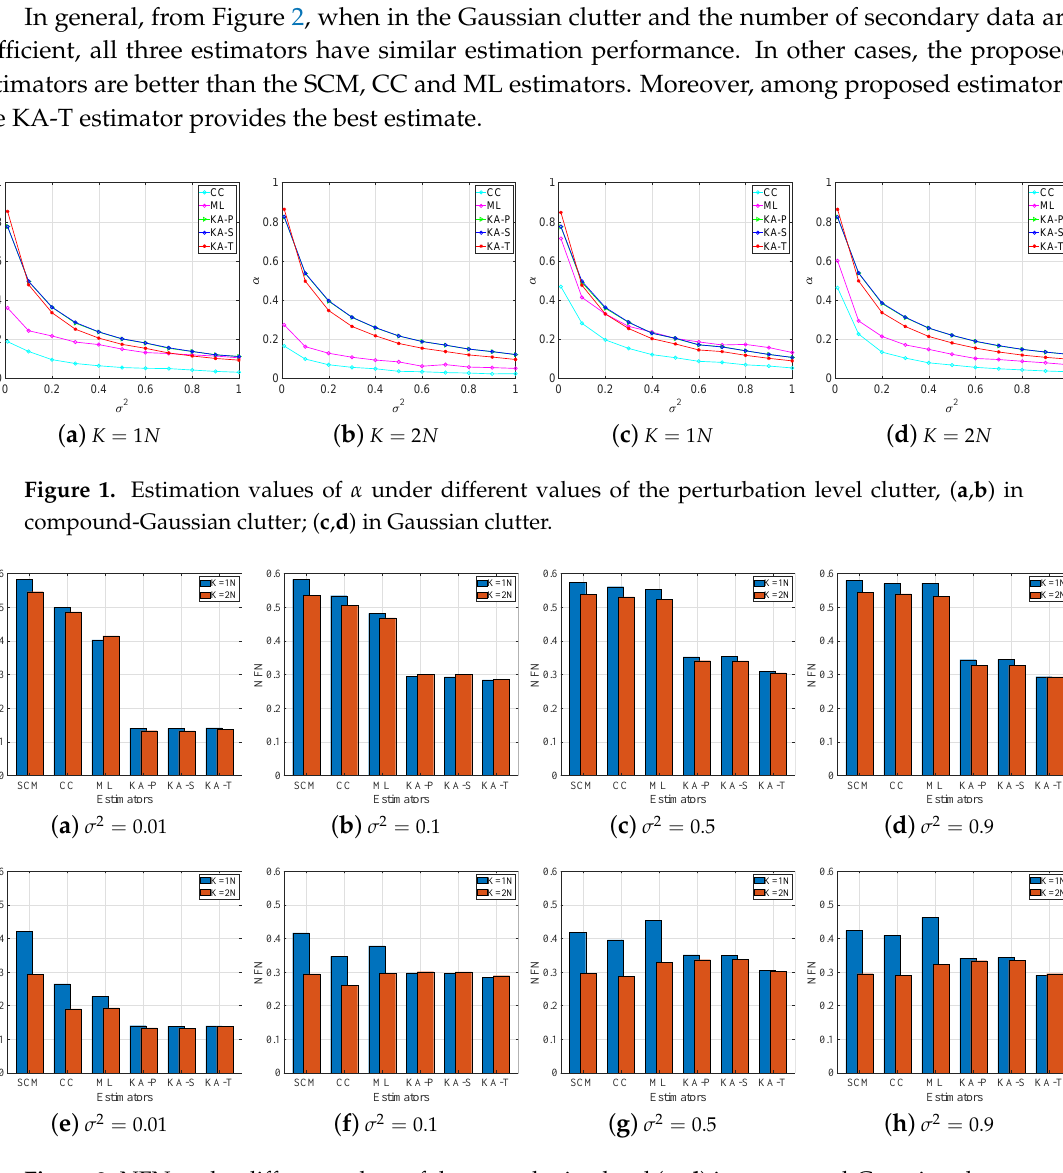
Figure 2. NFN under different values of the perturbation level ( a – d ) in compound-Gaussian clutter; ( e – h ) in Gaussian